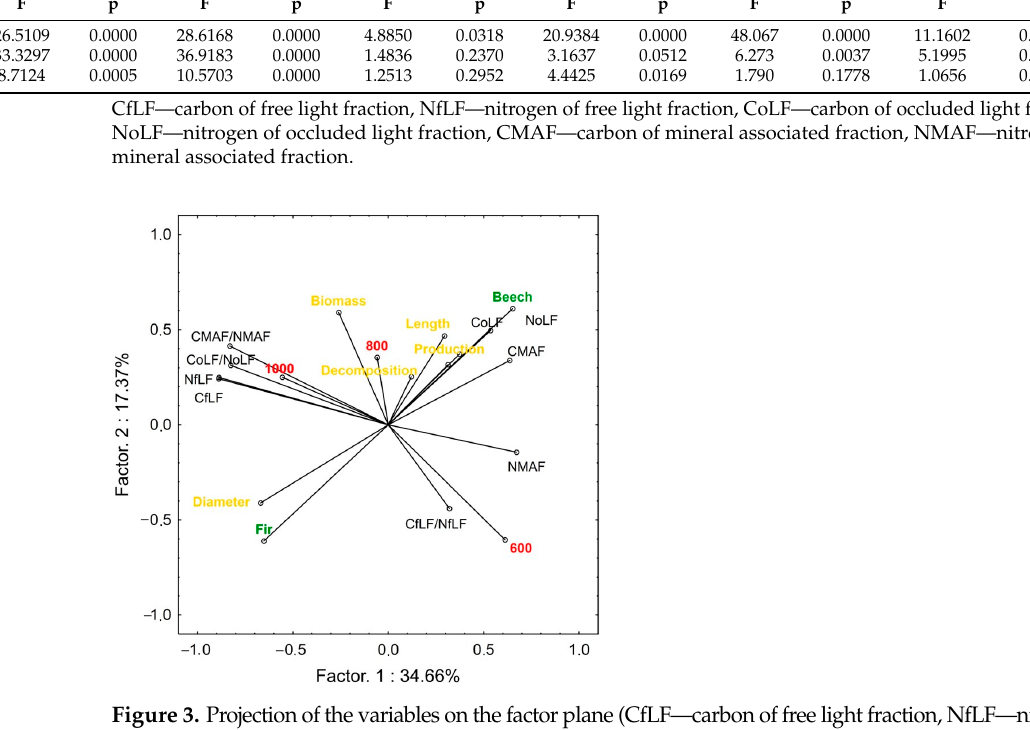
Figure 3. Projection of the variables on the factor plane (CfLF—carbon of free light fraction, NfLF—nitrogen of free light fraction, CoLF—carbon of occluded light fraction, NoLF—nitrogen of occluded light fraction, CMAF—carbon of mineral associated fraction, NMAF—nitrogen of mineral associated